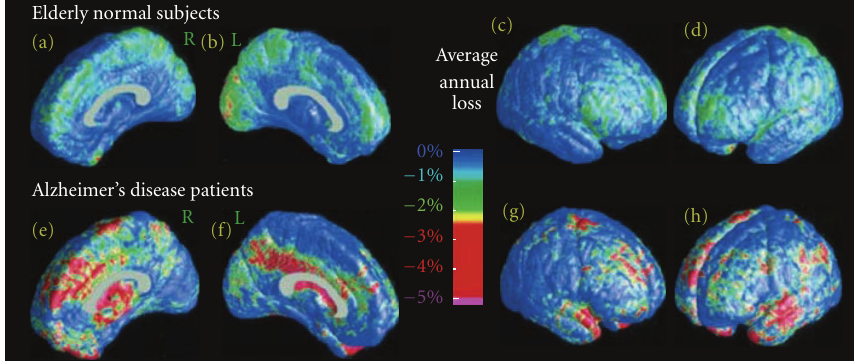
Figure 11: Average gray matter loss rates in healthy aging and AD. The maps show the average local rates of loss for gray matter, in groups of controls (top, (a)–(d)) and patients with AD (bottom, (e)–(h)). Loss rates are < 1% per year in controls. They are significantly higher in AD and strongest in frontal and temporal regions (g, h) at this stage of AD. (adapted with permission from